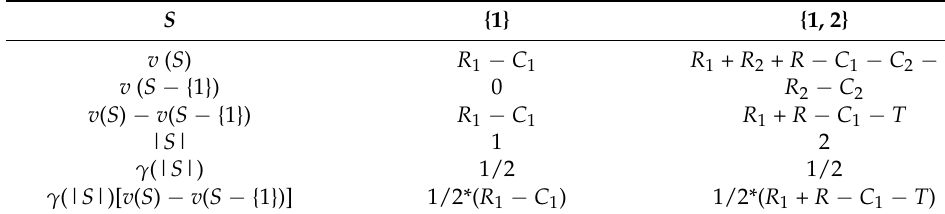
Table 4. Shapley value